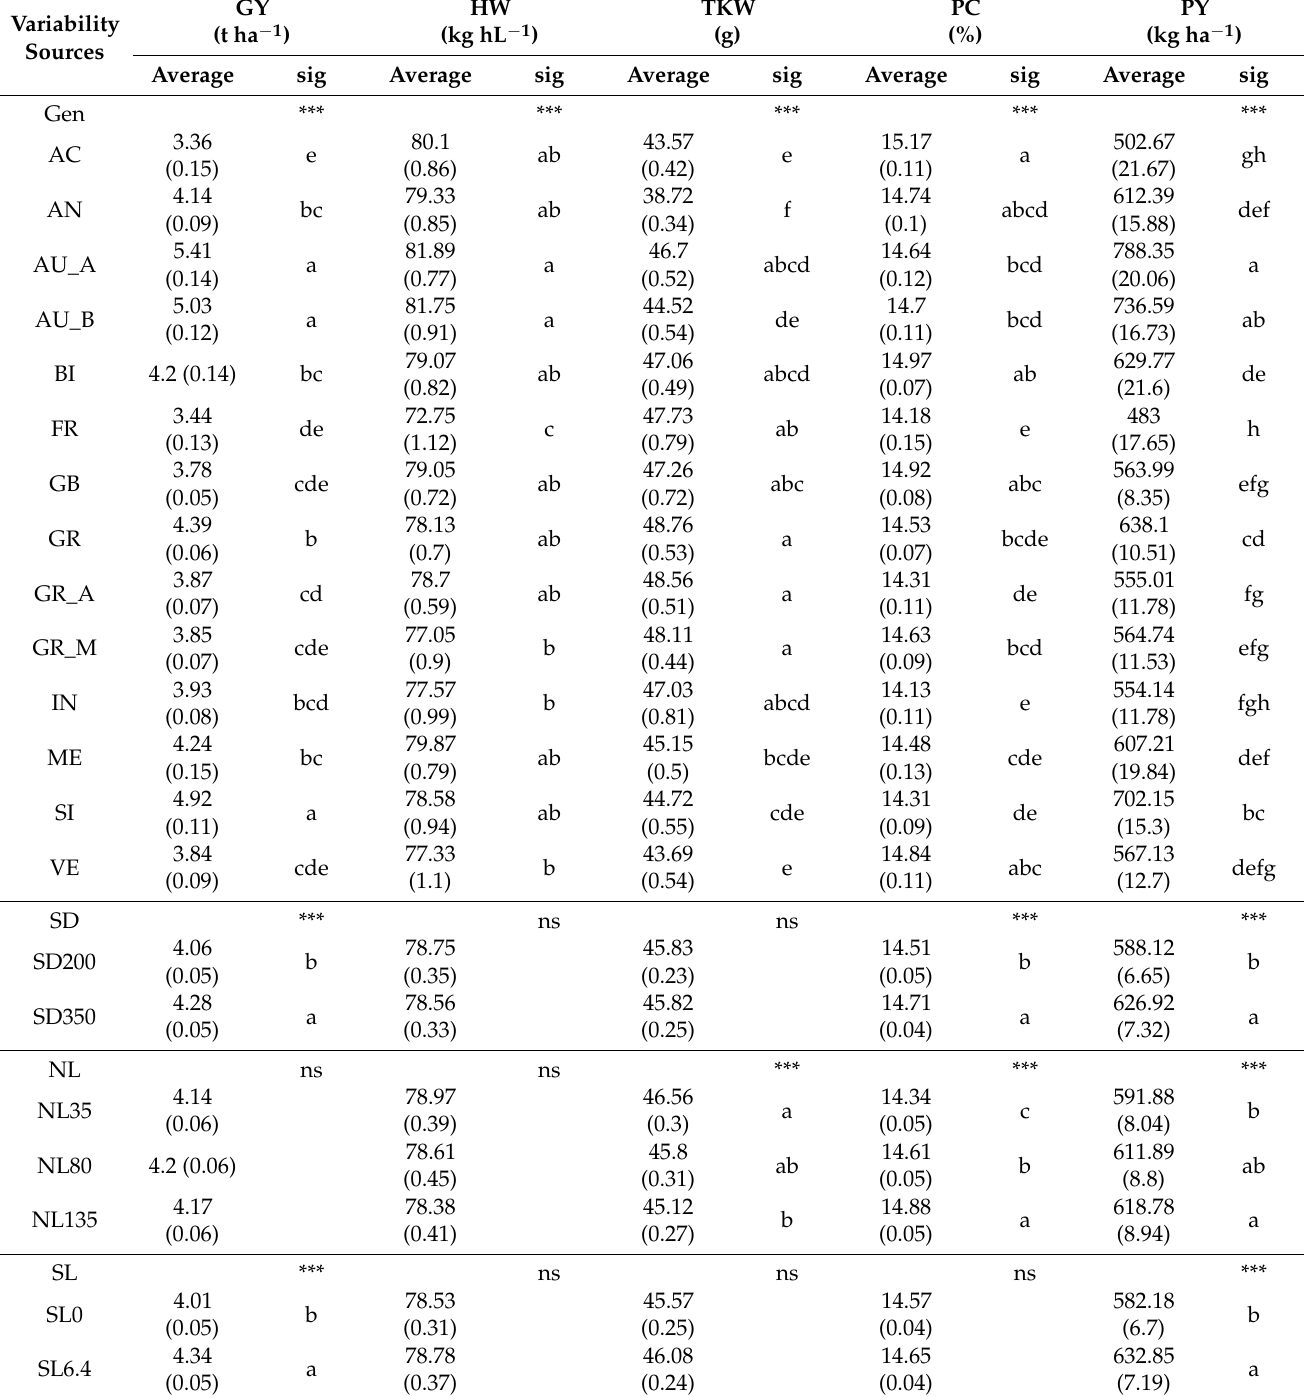
Table 4. Grain quality parameter mean values (standard error in brackets) of 14 old common wheat varieties as a function of genotype (Gen), nitrogen (NL) and sulfur fertilization (SL), and seeding density (SD). First-order interactions are provided for SD, NL, SL and Y. Lowercase letters represent the Tukey HSD post hoc test results. The table columns report the significance levels: *** = 0.001, ns = not